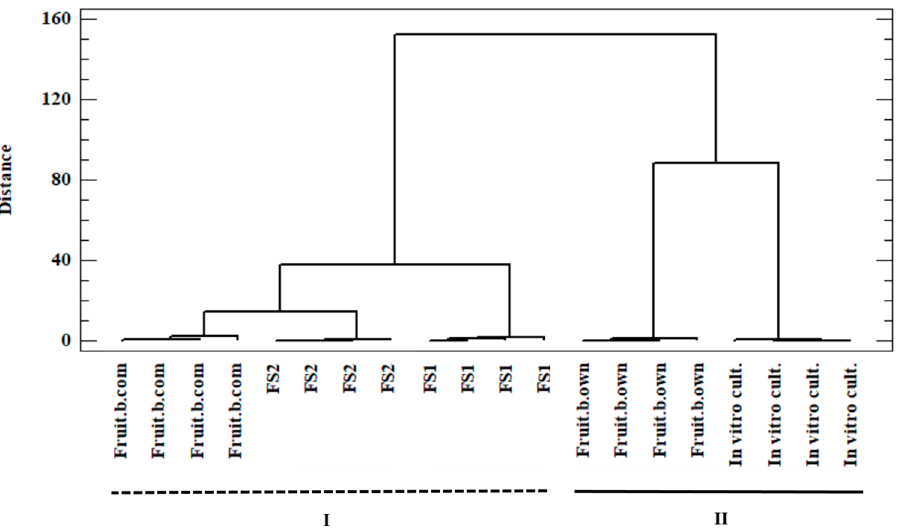
Figure 2. Dendrogram showing the existing correlation in the investigated data set between the analyzed objects—samples from C . militaris : In vitro cult.—mycelium from in vitro cultures, Fruit.b.own—fruiting bodies from own cultivation, Fruit.b.com—fruiting bodies from commercial cultivation, FS1—food supplement 1, FS2—food supplement 2 (Squared Euclidean, Ward’s algo-